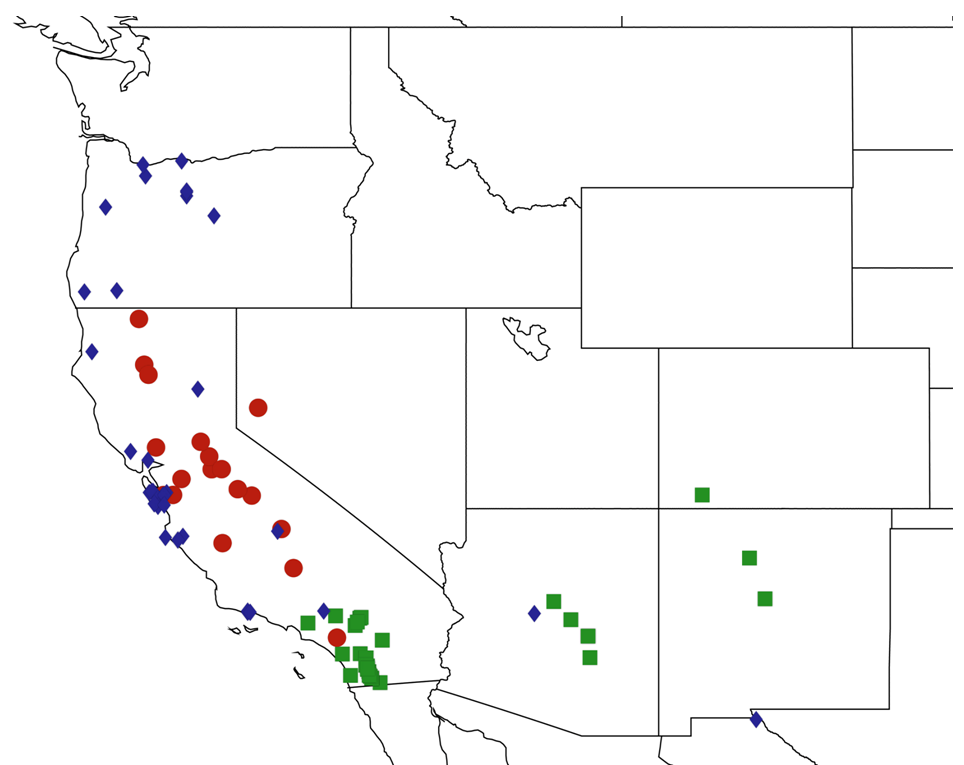
Figure 38. Distribution of Platypedia falcata (blue diamonds), P. mariposa (red circles), and P. bernardinoensis (green